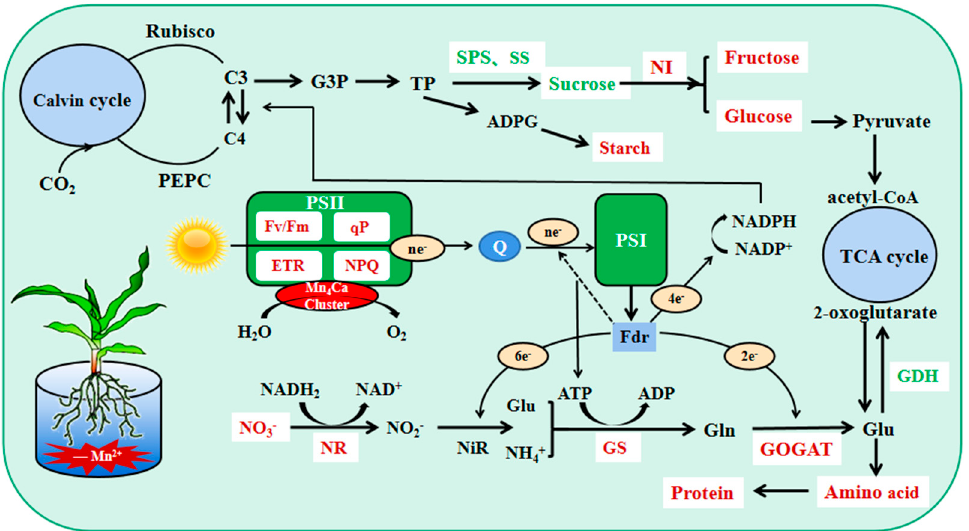
Figure 9. Physiological mechanism of the effect of Mn deficiency on carbon and nitrogen metab-olism in leaves of maize seedlings of tolerant genotype. Red indicates decrease in Mn deficiency, and green indicates increase in Mn deficiency.